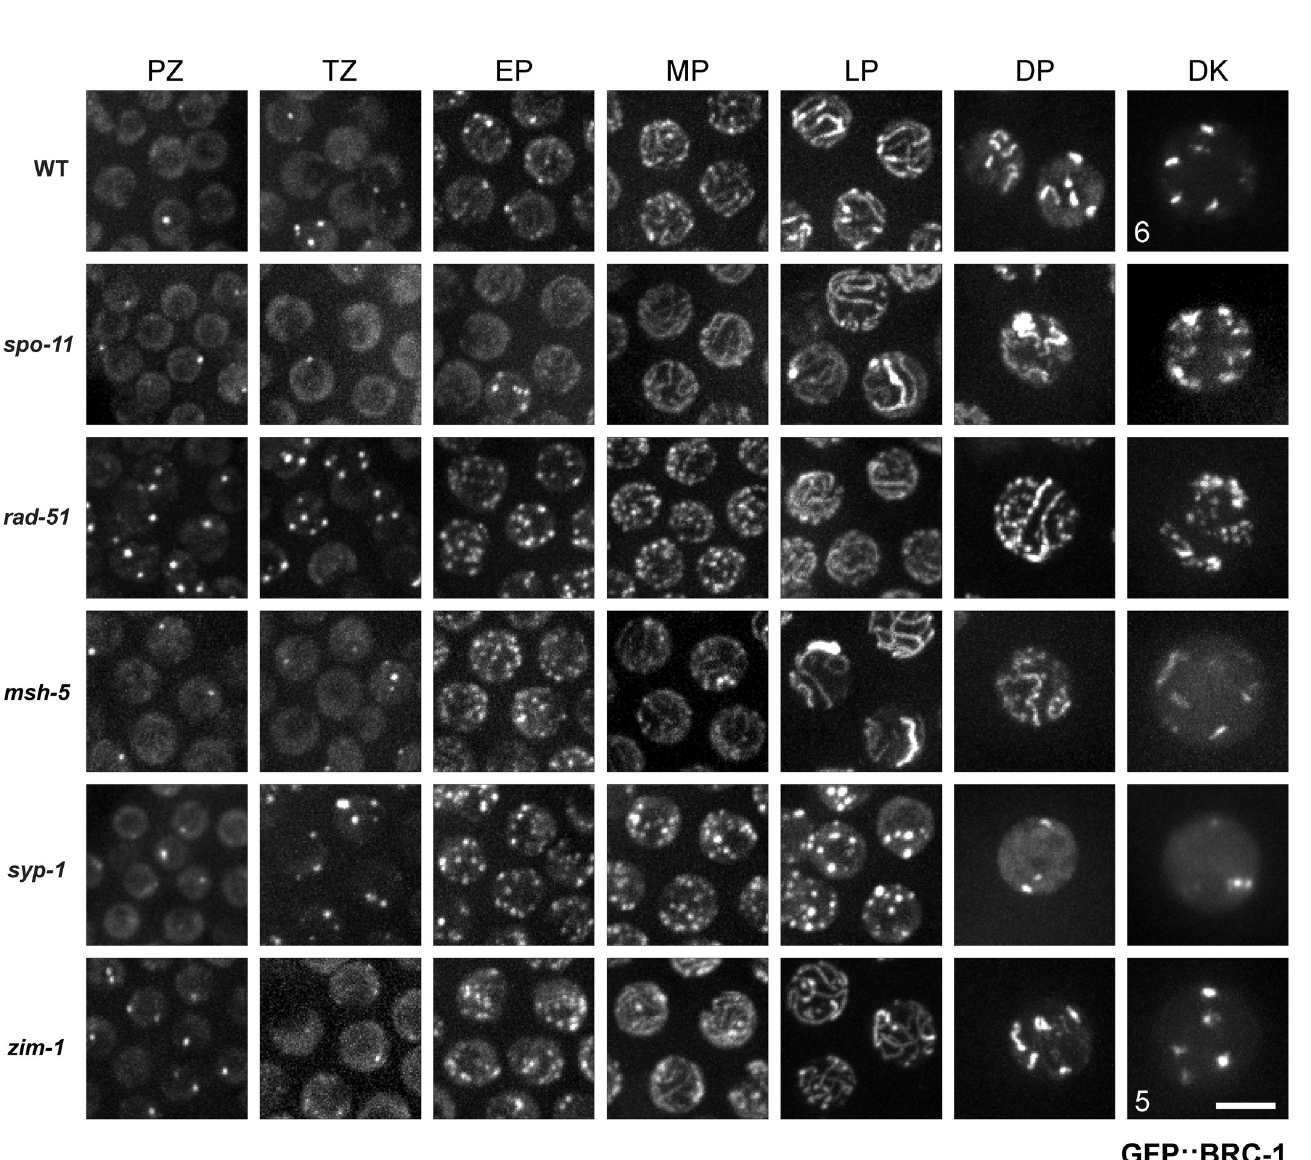
Fig 4. GFP::BRC-1 localization is perturbed when either meiotic recombination or chromosome synapsis is impaired. High-magnification images of live C . elegans expressing GFP::BRC-1 from the indicated genetic backgrounds and gonad region (PZ = Proliferative Zone, TZ = Transition Zone, EP = Early Pachytene, MP = Mid Pachytene, LP = Late Pachytene, DP = Diplotene, DK = Diakinesis). In wild-type worms GFP::BRC-1 localizes to chromatin and in a small number of foci in the proliferative and transition zones. GFP::BRC-1 localizes to long tracks corresponding to the SC in mid-pachytene. In late pachytene, GFP::BRC-1 becomes condensed to one side of each chromosome, demarcating what will become the short arms of the six bivalents in diakinesis (WT = 6). This localization pattern is perturbed when synapsis and crossover formation are disrupted. A zim-1 diakinesis nucleus with 5 GFP::BRC-1 short stretches is shown. Images are projections through half of the gonad. Scale bar = 5 μ m. Following DSB formation and processing, RAD-51 is loaded onto resected single-stranded DNA and facilitates strand exchange [36]. GFP::BRC-1 localization was altered in the rad-51 mutant (Fig 4). Significantly increased levels of GFP::BRC-1 foci were observed throughout the germ line. In the proliferative zone, wild type had 0.55 ± 0.04, while rad-51 had 0.96 ± 0.10 foci per nucleus (S2A Fig). These most likely represent concentration of GFP::BRC-1 at